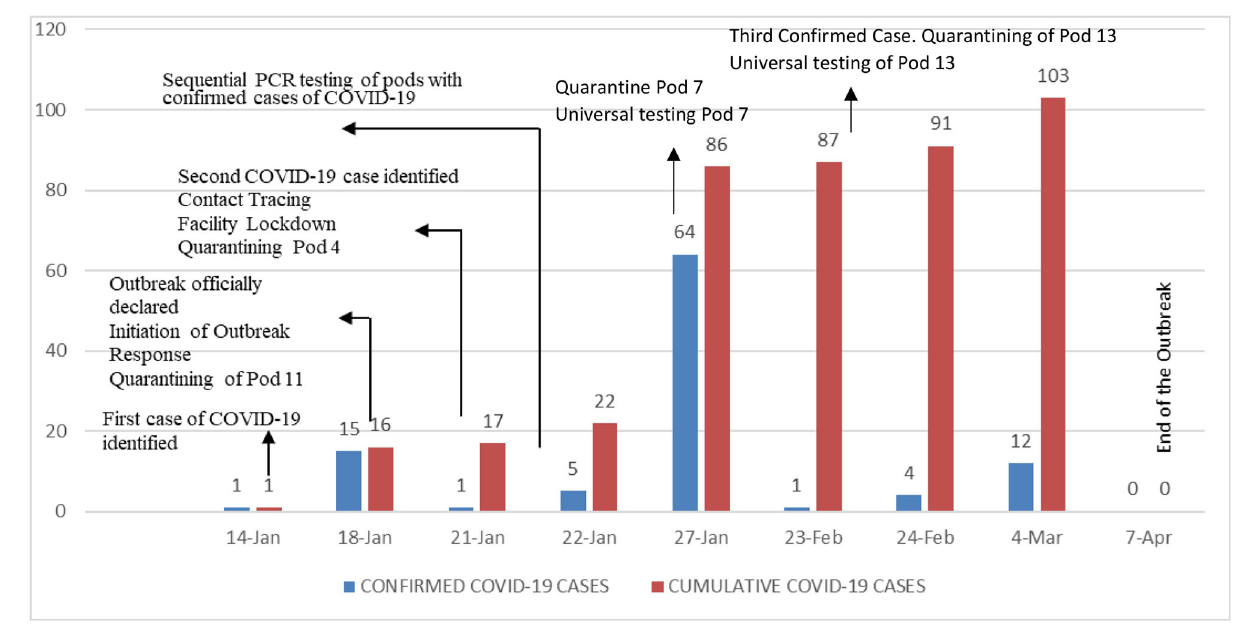
FIGURE 1 | Timing of COVID-19 cases and institution of specific mitigation interventions.